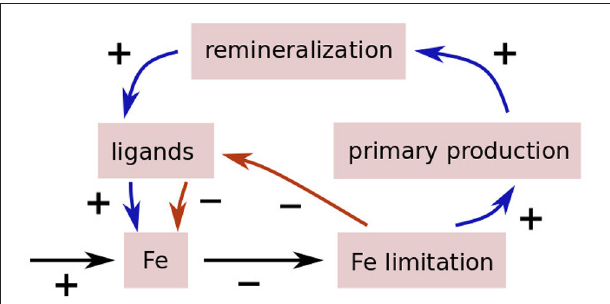
FIGURE 1 | Illustration of the two feedback loops, one destabilizing (blue), the other stabilizing (red).